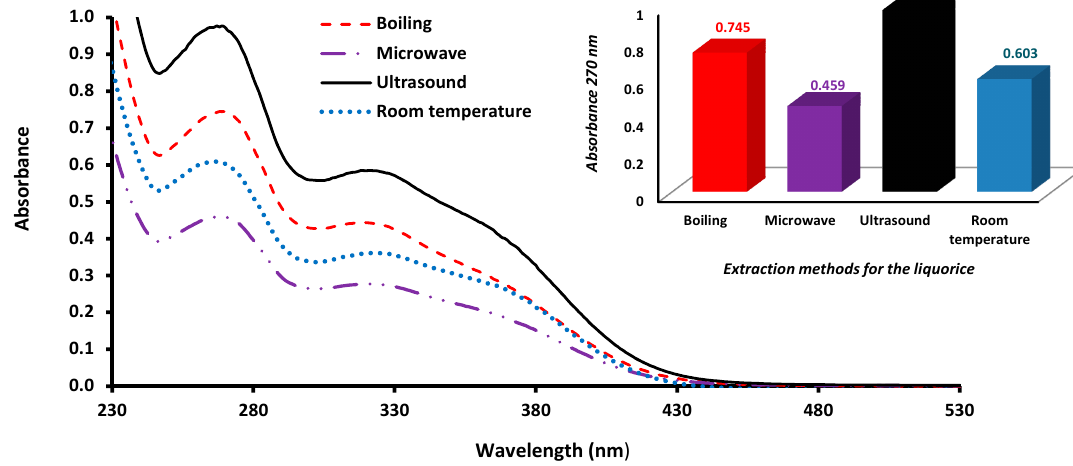
Figure 5. Evolution of absorption curves according to the wavelength and comparison of the absorption levels from λ max for the licorice sample supernatants activated by the four conditions.